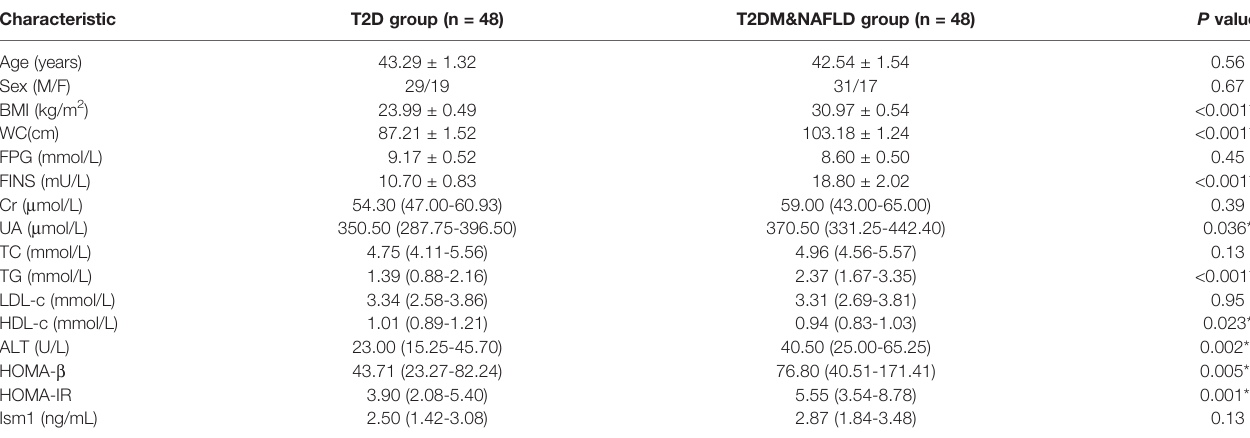
TABLE 4 | Clinical characteristics of the T2D group and T2D&NAFLD group.